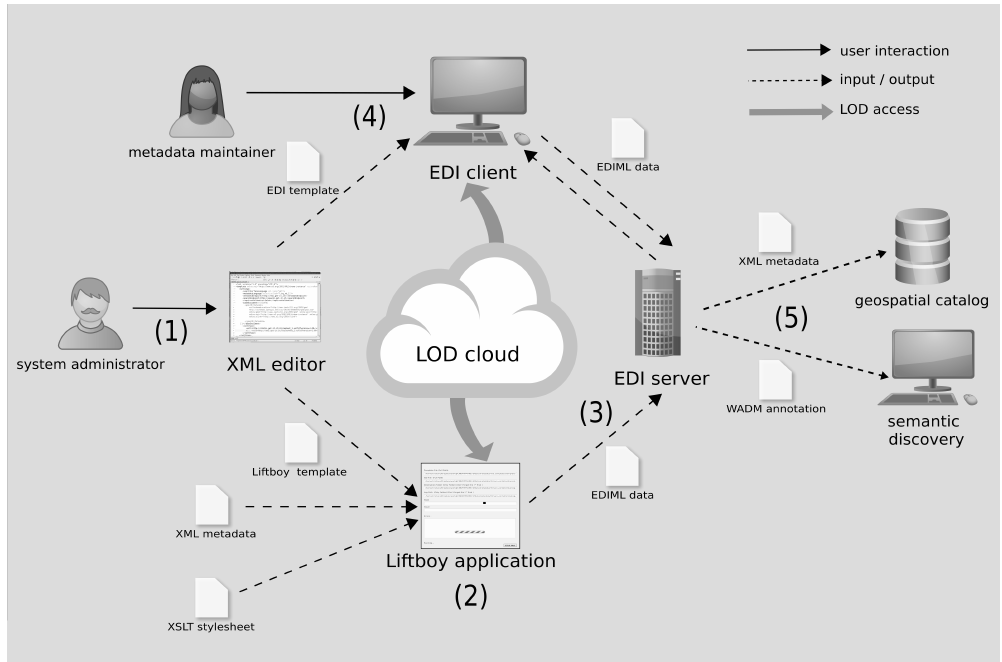
Figure 3. Overview of workflows for semantic lift through